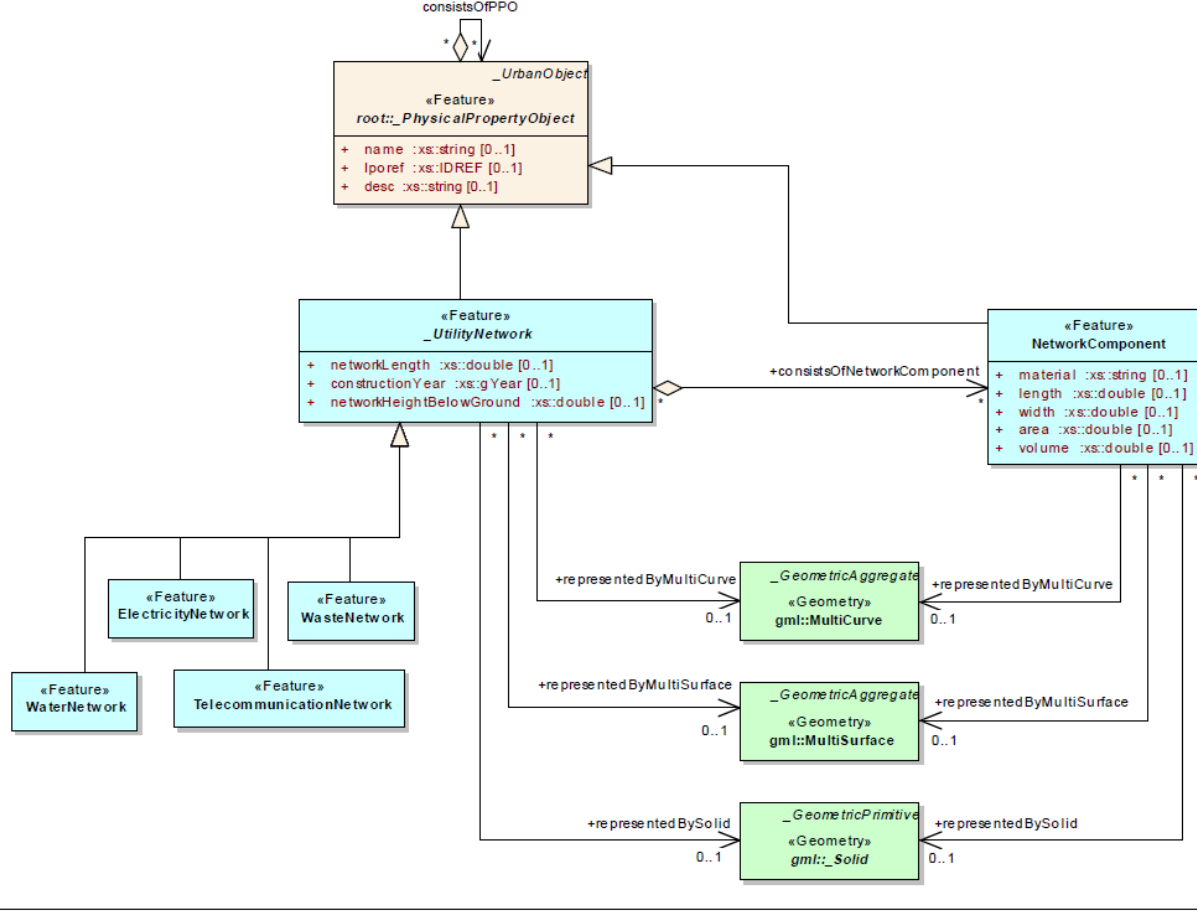
Figure 21. The UML diagram of 3DCDM UtilityNetwork